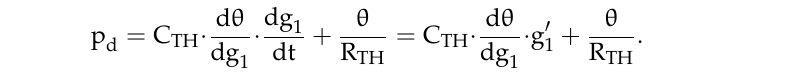
Figure 4. Thermal model of an SC based on an analogy with an electrical circuit.